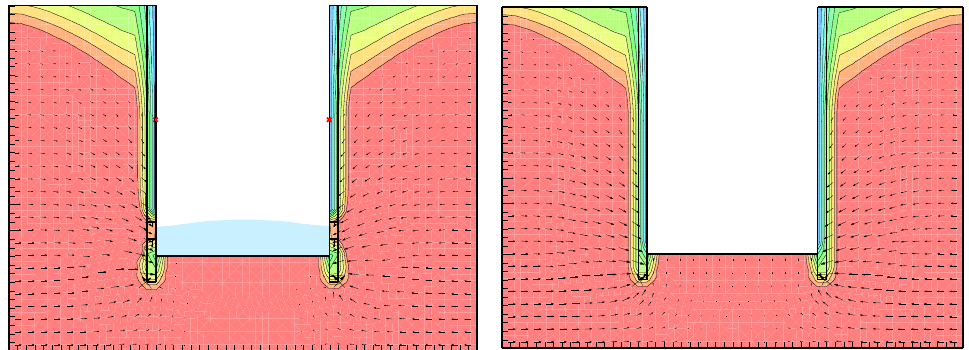
Figure 7. Underground flow path diagram of retaining structure with leakage ( left ) and without leakage ( right ).